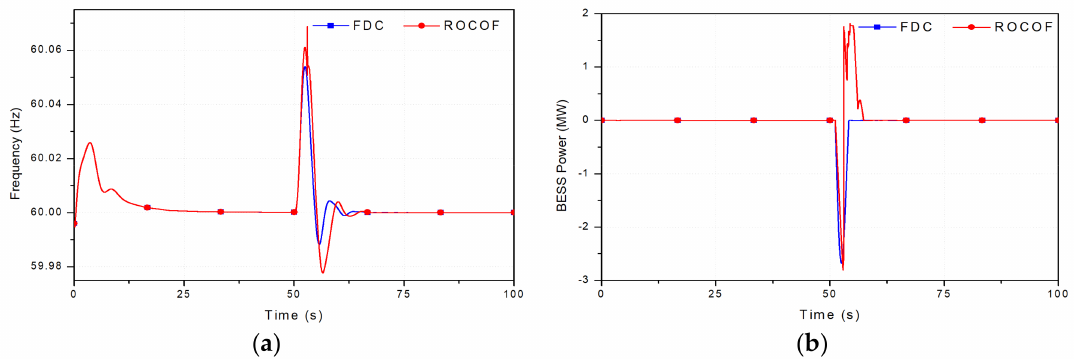
Figure 21. BESS output and frequency result when wind speed is increased (0~100 s): ( a ) Frequency; ( b ) BESS